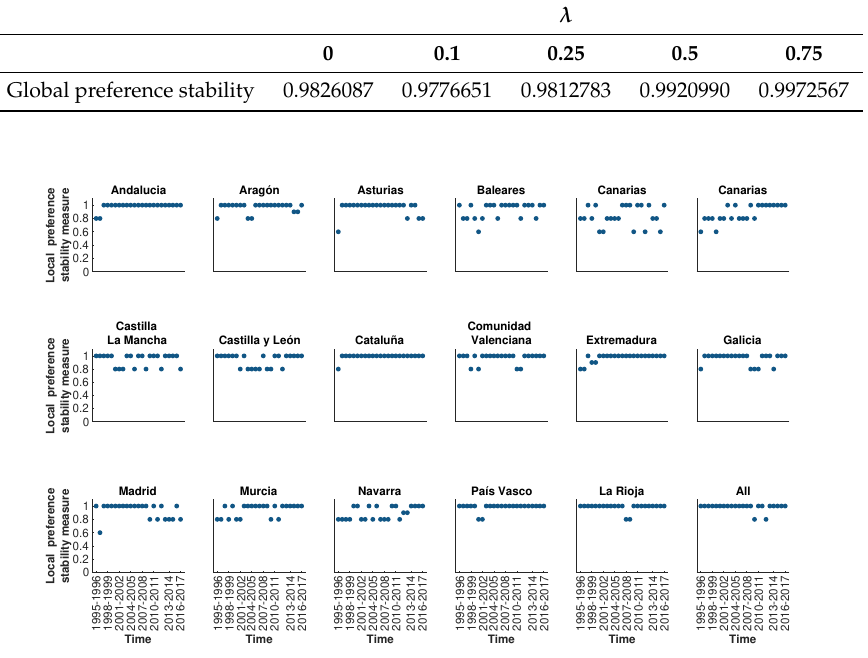
Figure A3. Graphic illustration of the local decision stability measures for Question 1 obtained for each